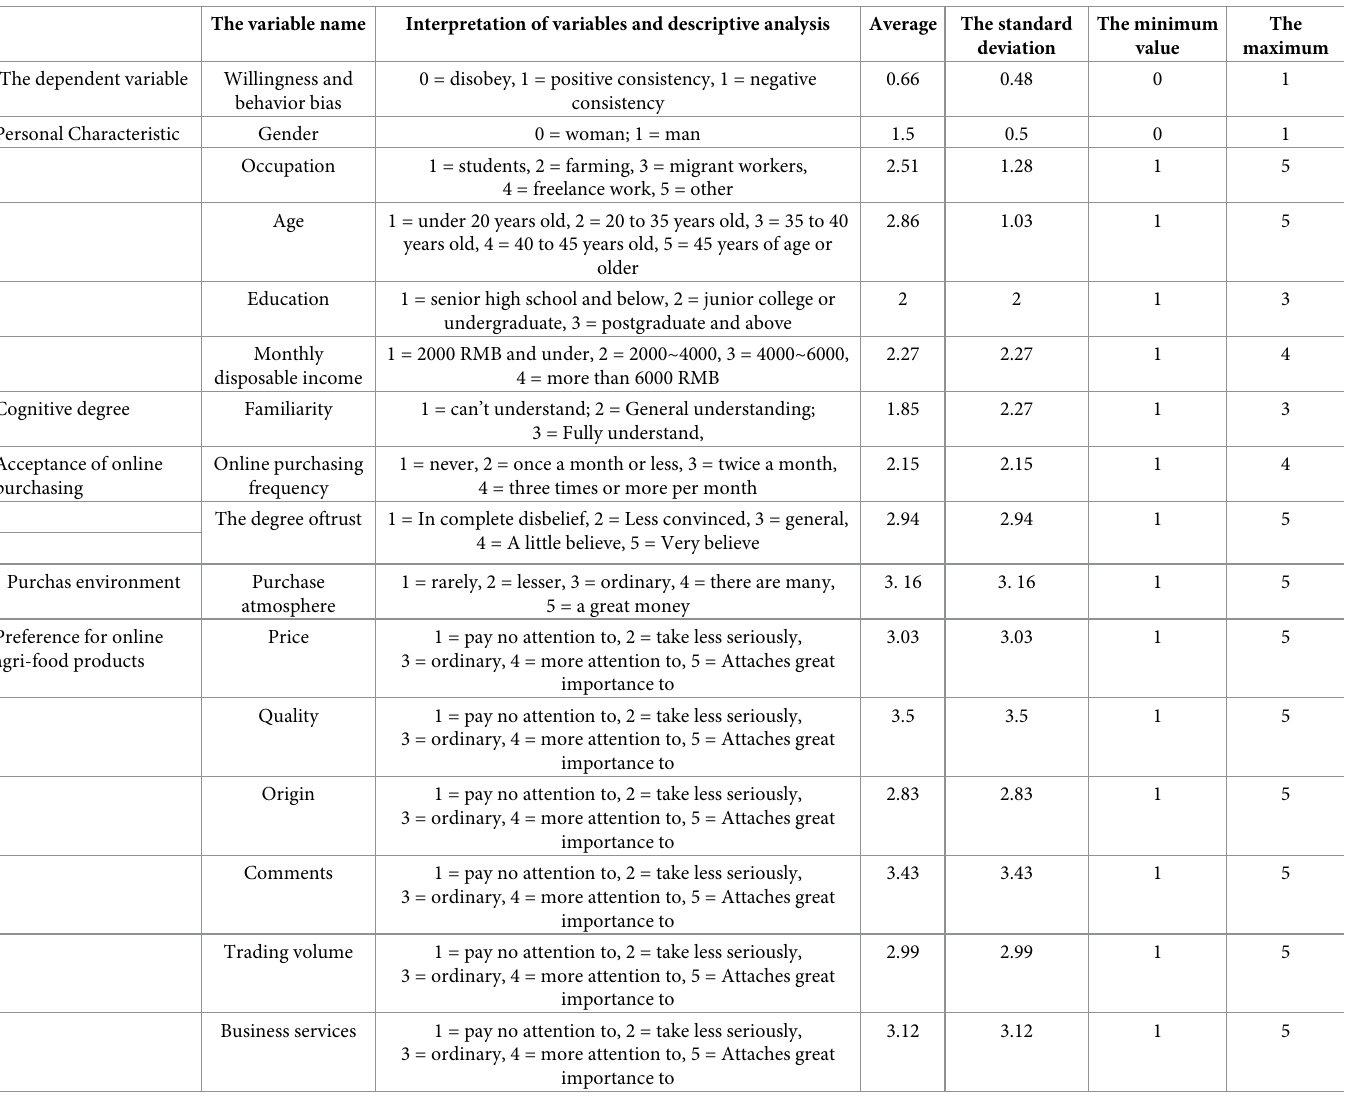
Table 2. The descriptive statistics of each